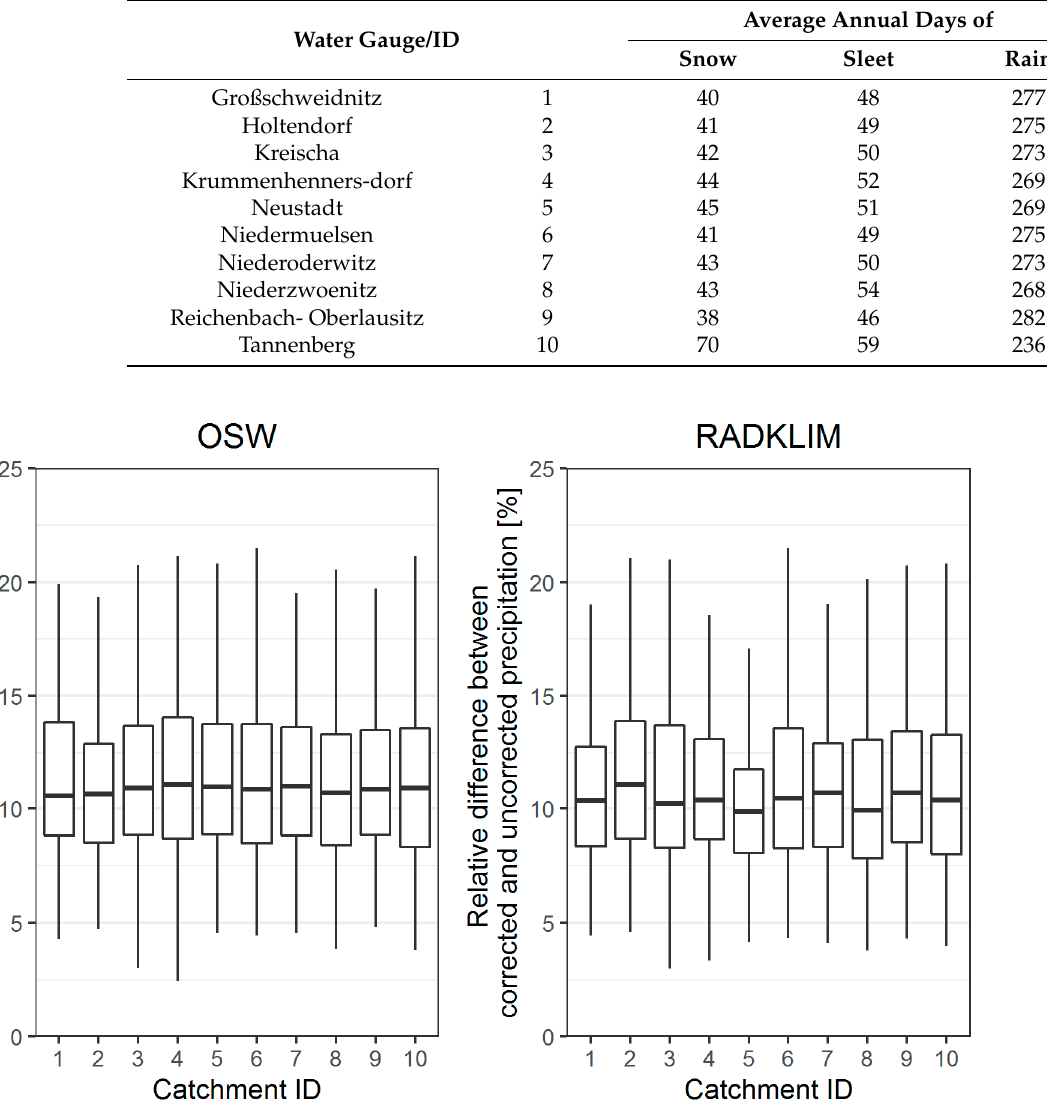
Figure 4. Relative difference between the monthly corrected precipitation after Richter correction for the OSW and RADKLIM datasets in the period 2006–2017. Table 2. Average days for each type of precipitation classified with mean temperature (Appendix C) for the ten selected catchments in the period 2001–2017.